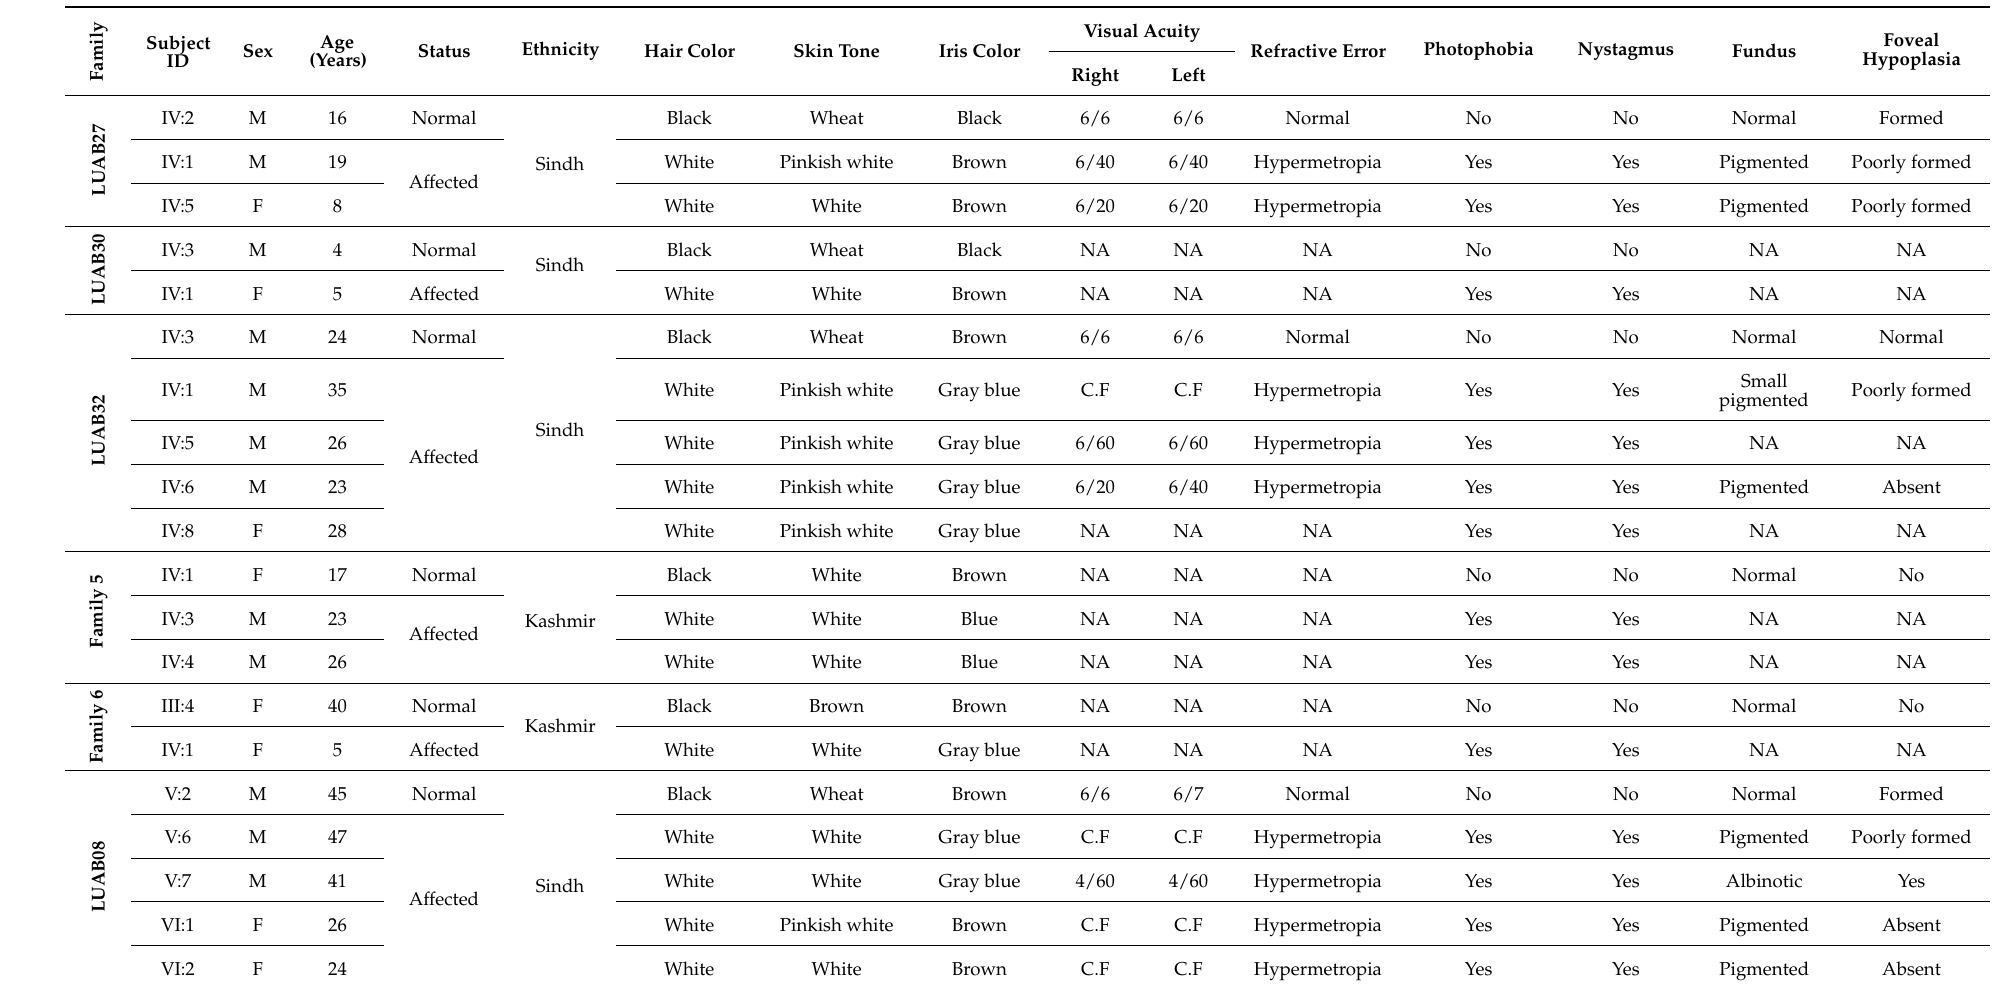
Table 1. Clinical findings of OCA-affected families from Pakistan.